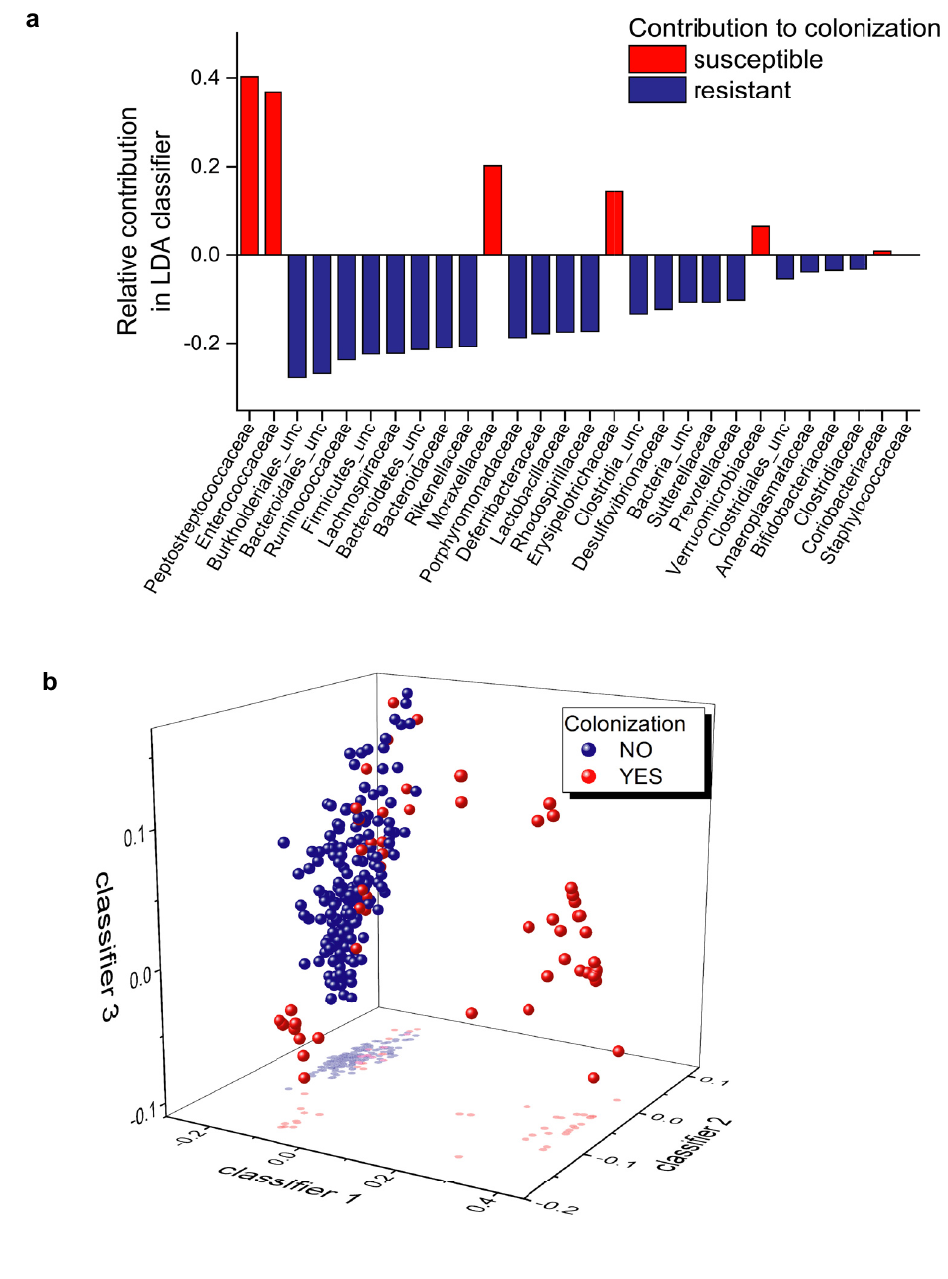
Fig 9. RLDA identifies families that contribute to colonization susceptibility. (A) Regularized Fisher’s linear discriminant analysis (RLDA) was performed using the relative abundance data collected from germ-free mice administered FMT from WT and MR1 -/- SPF mice and colonization status as in Fig 5. The relative contribution of bacterial colonies differentiates the samples that undergo colonization and samples that do not. Bacteria are ordered in descending order of importance. (B) 3-D plot depicts RLDA of colonization status of previously germ-free mice. Colonized samples (red dots) vs non-colonized samples (blue dots) are arranged based on differentiator vectors. Samples are colored based on final colonization status, no stratification was performed based on